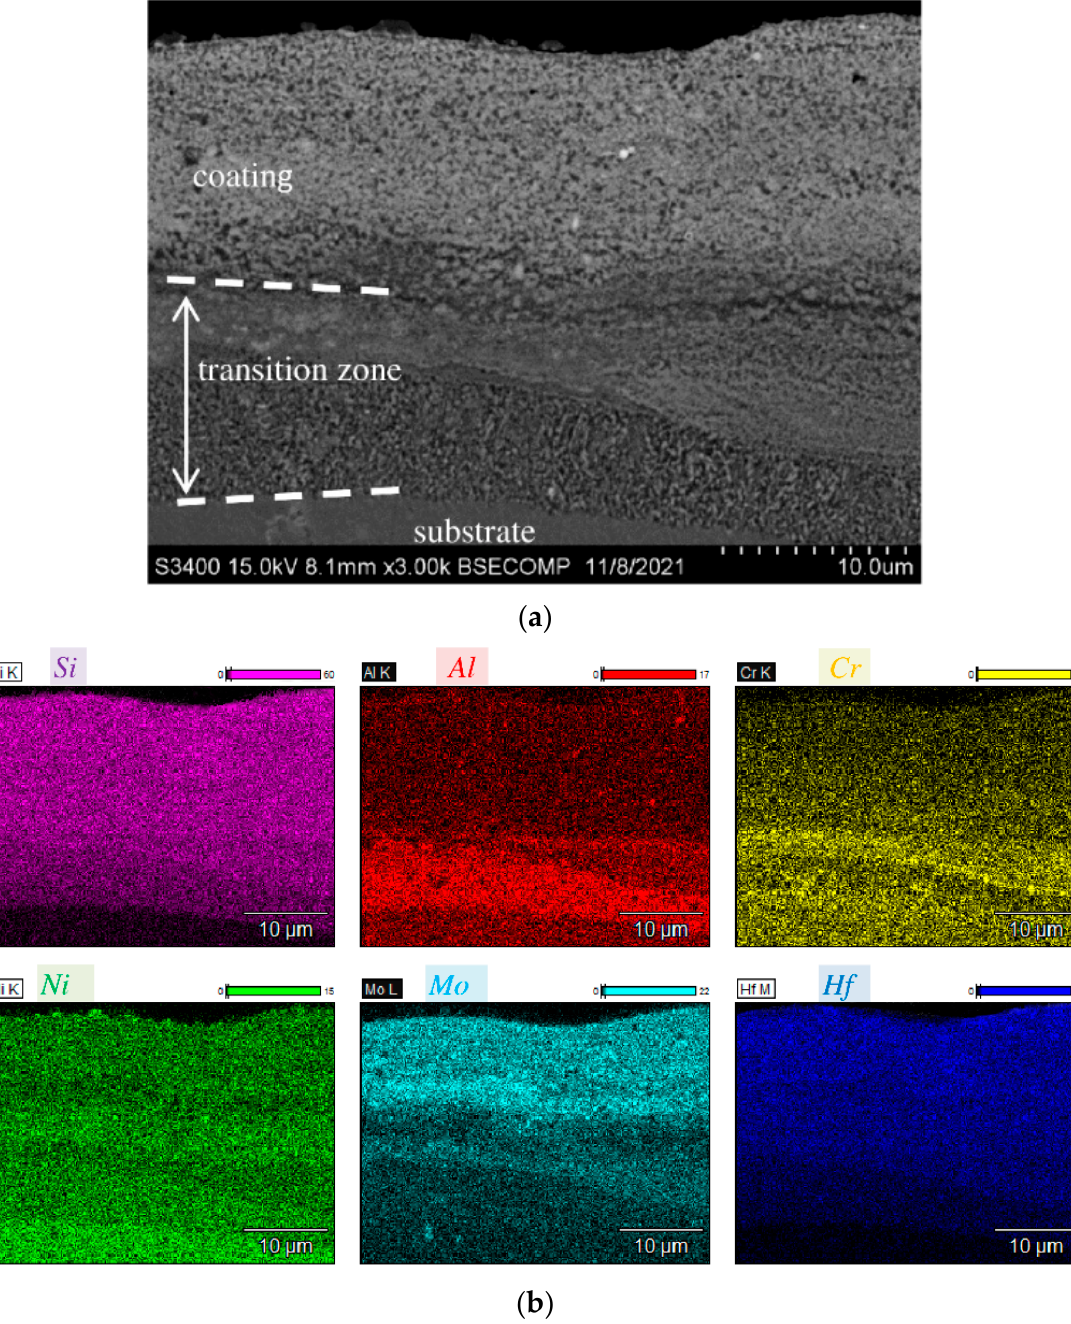
Figure 3. Cross-sectional SEM image ( a ) and corresponding EDS elemental maps ( b ) of the coating after vacuum annealing.